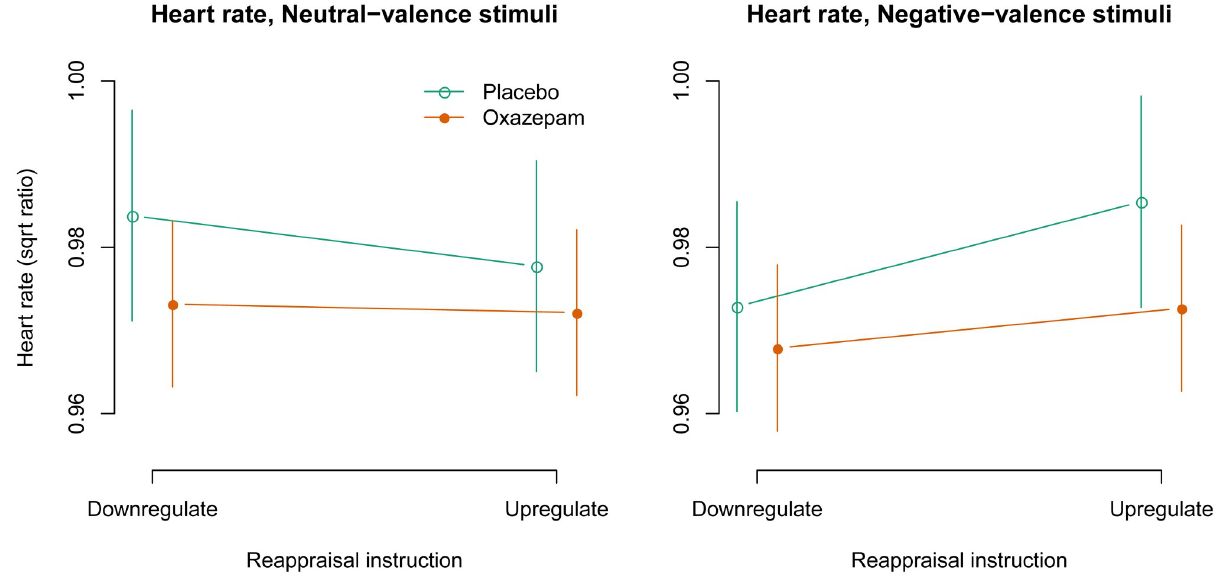
Fig 8. Heart rate: Model estimates with 95% confidence